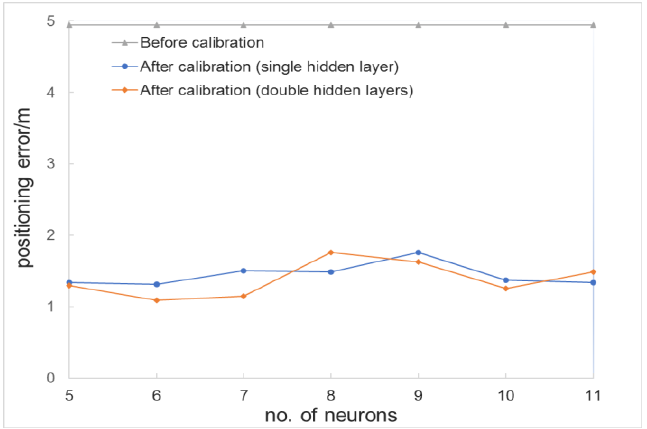
Figure 12. Comparison of average positioning error before and after calibration of test mobile terminal 1.